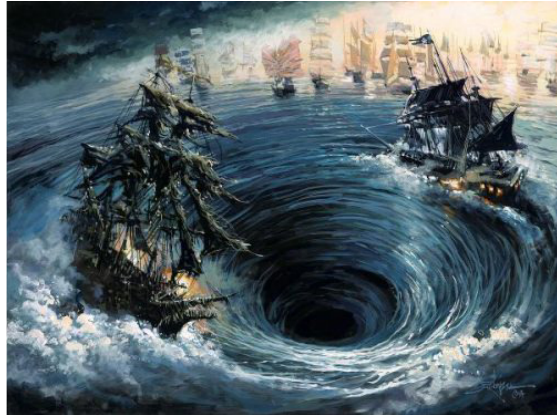
Figure 9. Ocean whirlpools in legends. Illustration by unknown